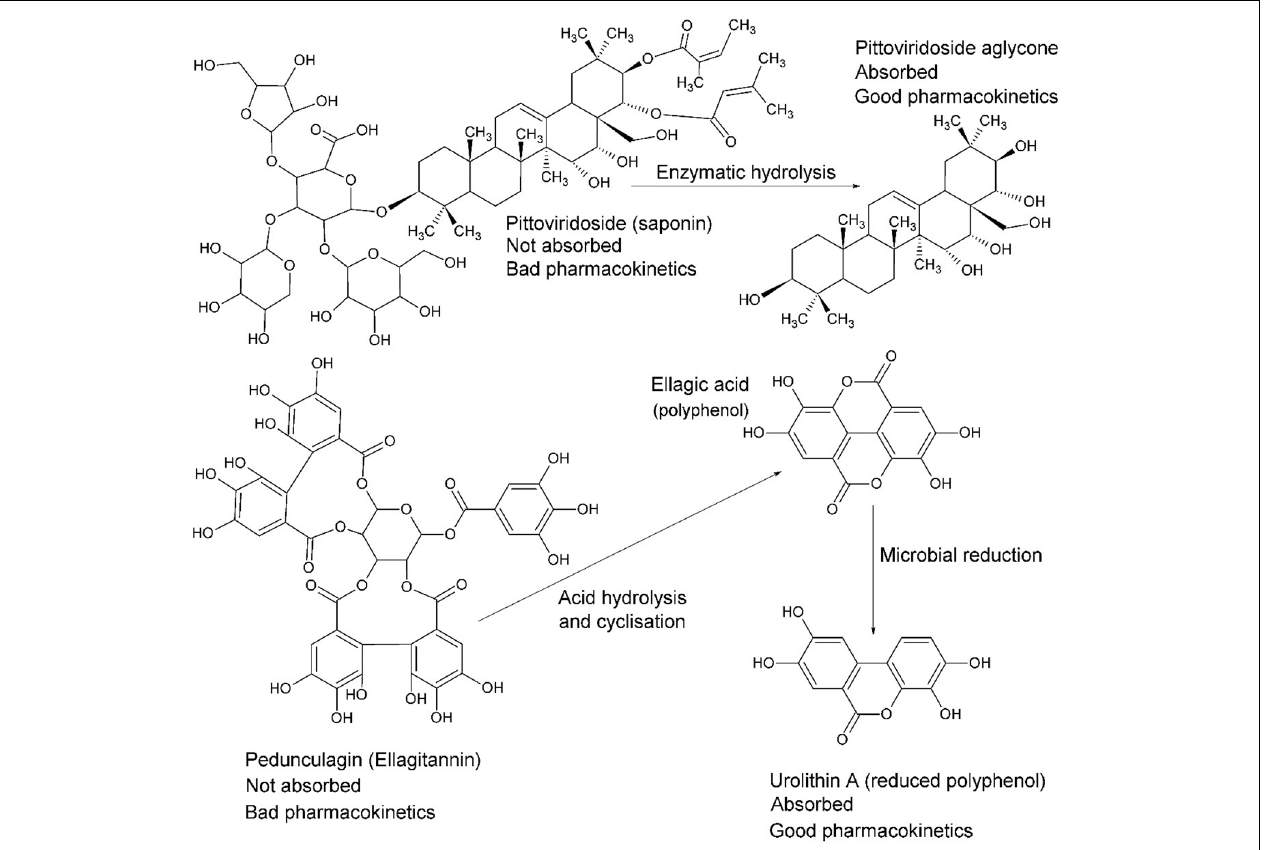
FIGURE 8 | The fate of complex glycosides in human digestion involves cleavage of sugar moieties, either by β -glucosidases of the small intestine (or bacteria) in the case of saponins, such as pittoviridoside (Seo et al., 2002), or by acid hydrolysis in the stomach, such as pedunculagin (Seeram et al., 2004). Ellagic acid is metabolized into urolithin A by gut bacteria before absorption; however, both are systemic. The pentacyclic triterpene of pittoviridoside is absorbed after hydrolysis of the sugar and butenoic ester